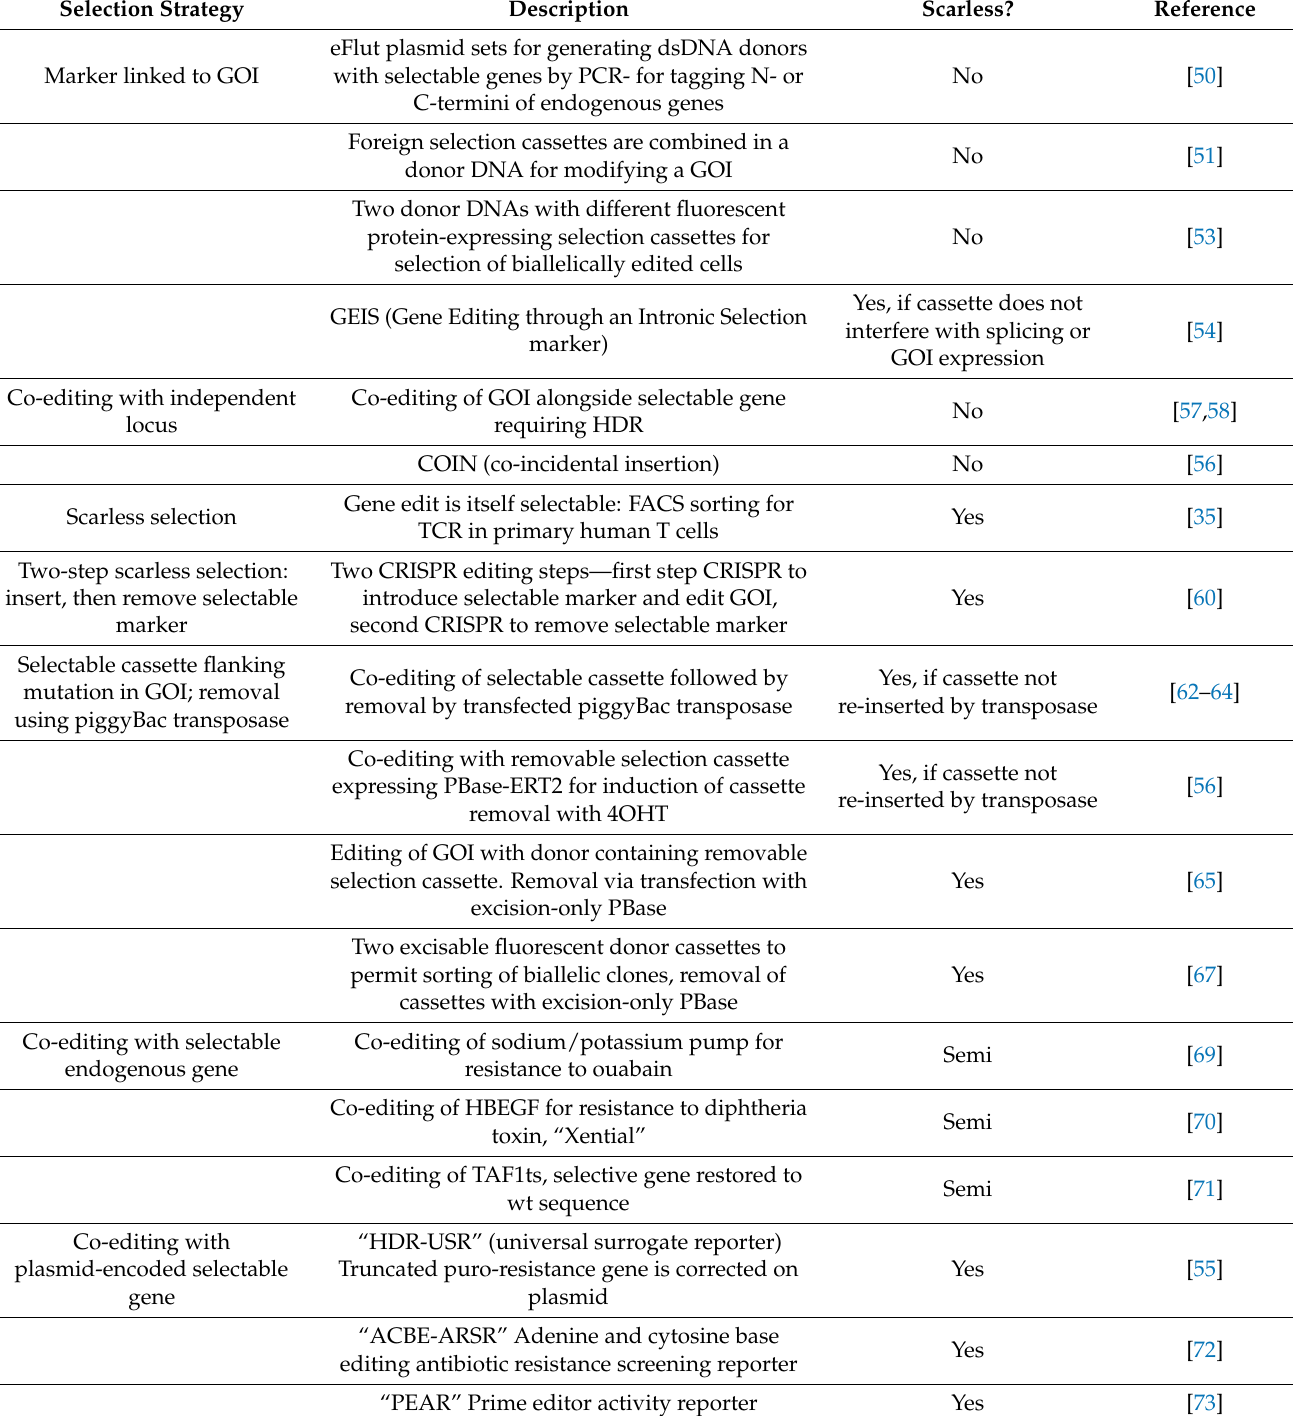
Table 1. Selection strategies for CRISPR-edited